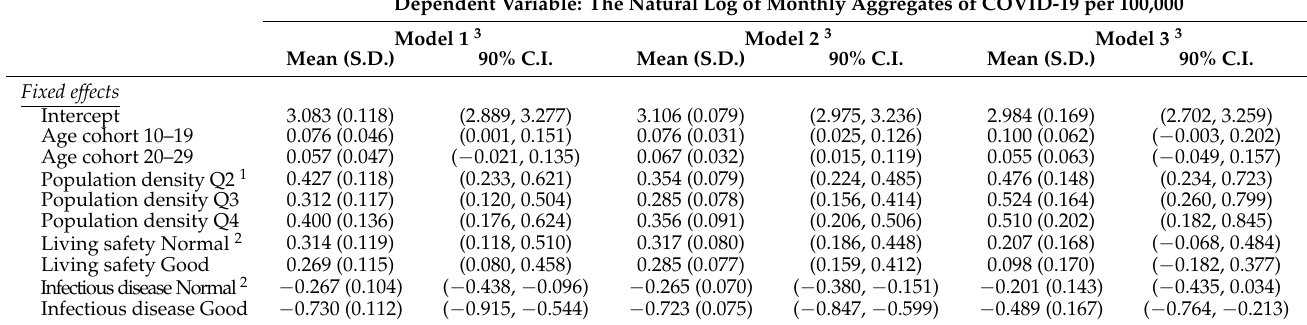
Table 2. Regression